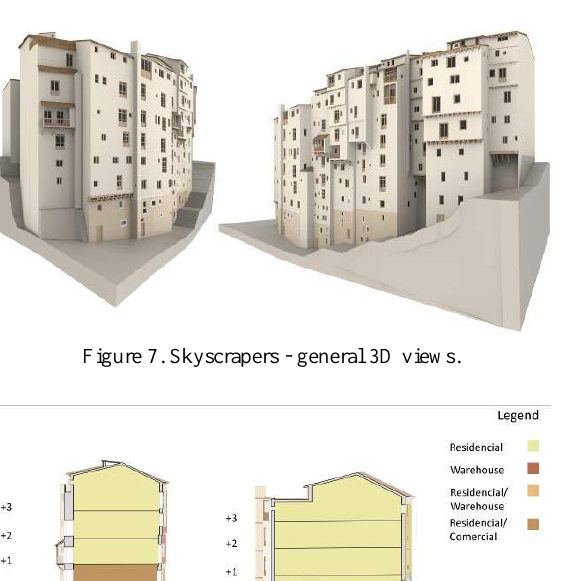
Figure 6. Façades of skyscrapers.